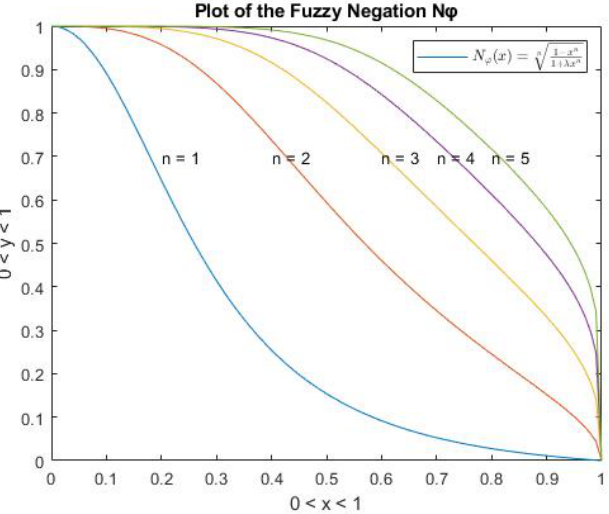
Figure 2. Fuzzy negations generated from Sugeno class using an automorphism function.